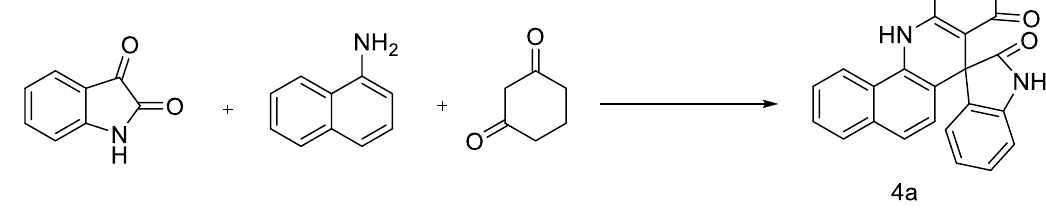
Figure 1. Synthesis of compound 4a.